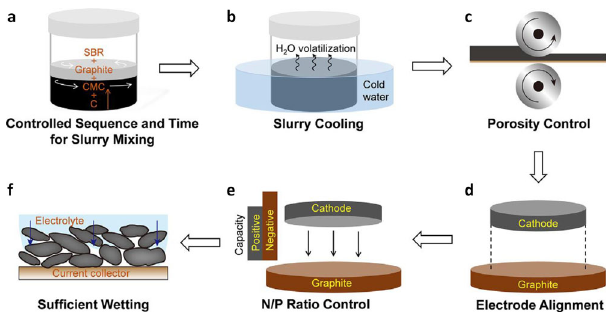
Fig. 1 Critical steps and parameters for preparing high quality graphite- based full coin cells. a Slurry mixing step; b Cooling of slurry after mixing; c porosity control in calendaring process; d Electrode alignment during full cell fabrication; e N/P ratio control for full cell; f Electrolyte wetting on electrodes. (reprint with permission from ref. 15 . Copyright 2021 Cell